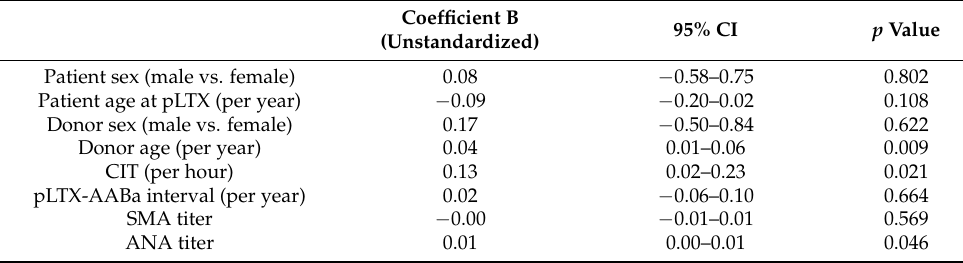
Table 6. Characteristics associated with ISHAK fibrosis score (0–6) in multiple linear regression (n = 78). Coefficient B 95% CI p Value (Unstandardized) Patient sex (male vs. female)